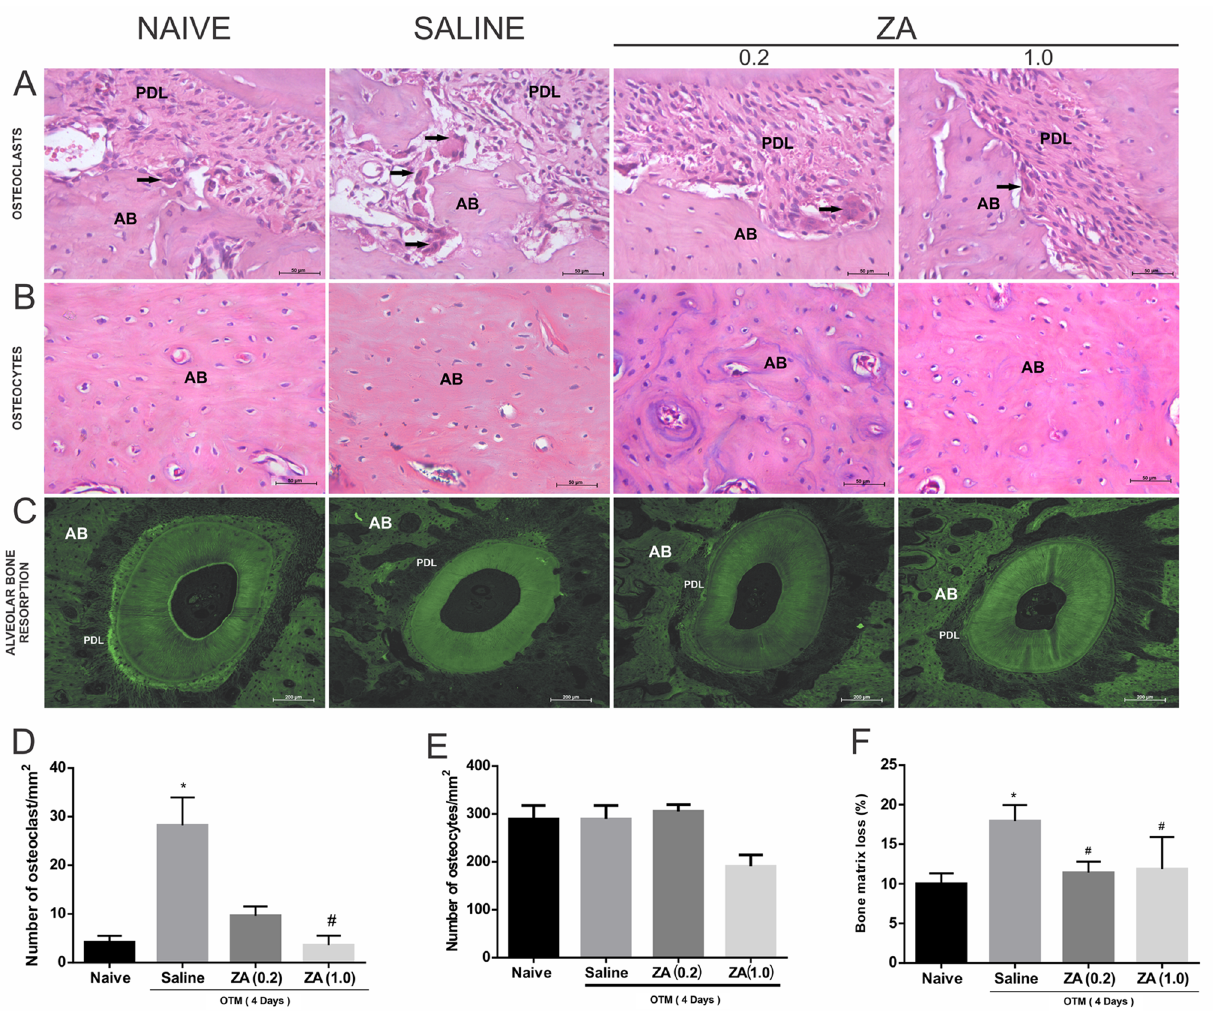
Figure 5. Analysis of the effect of ZA on alveolar bone in the Naive, Saline, ZA (0.2) and ZA (1.0) experimental groups. (A) Osteoclastic cells in the bone matrix of the alveolar bone in the DV root. AB alveolar bone, PDL periodontal ligament. The black arrow indicates osteoclastic cells. (B) Osteocytes in the alveolar bone matrix. (A,B) The bars indicate 50 µm, HE staining, × 400 magnitude. (C) Histopathological analysis of the resorption of the alveolar bone on the compression side by confocal microscopy of the root DV, × 100 magnitude. (D) Number of osteoclastic cells in the alveolar bone. Bars represent mean ± SEM of 6 animals per group. (*) indicates difference when compared to the naive group, (#) indicates difference when compared to the saline group (Kuskal–Wallis test p = 0.001 and Dunn’s pos-hoc test). (E) Number of osteocyte cells in the alveolar bone. (F) Analysis of the levels of loss in the alveolar bone matrix. Bars represent mean ± SEM of 6 animals per group. (*) indicates difference when compared to the naive group. (#) indicates difference when compared to the saline group (ANOVA p = 0.019, Levene p = 0.103 and Tukey pos-hoc